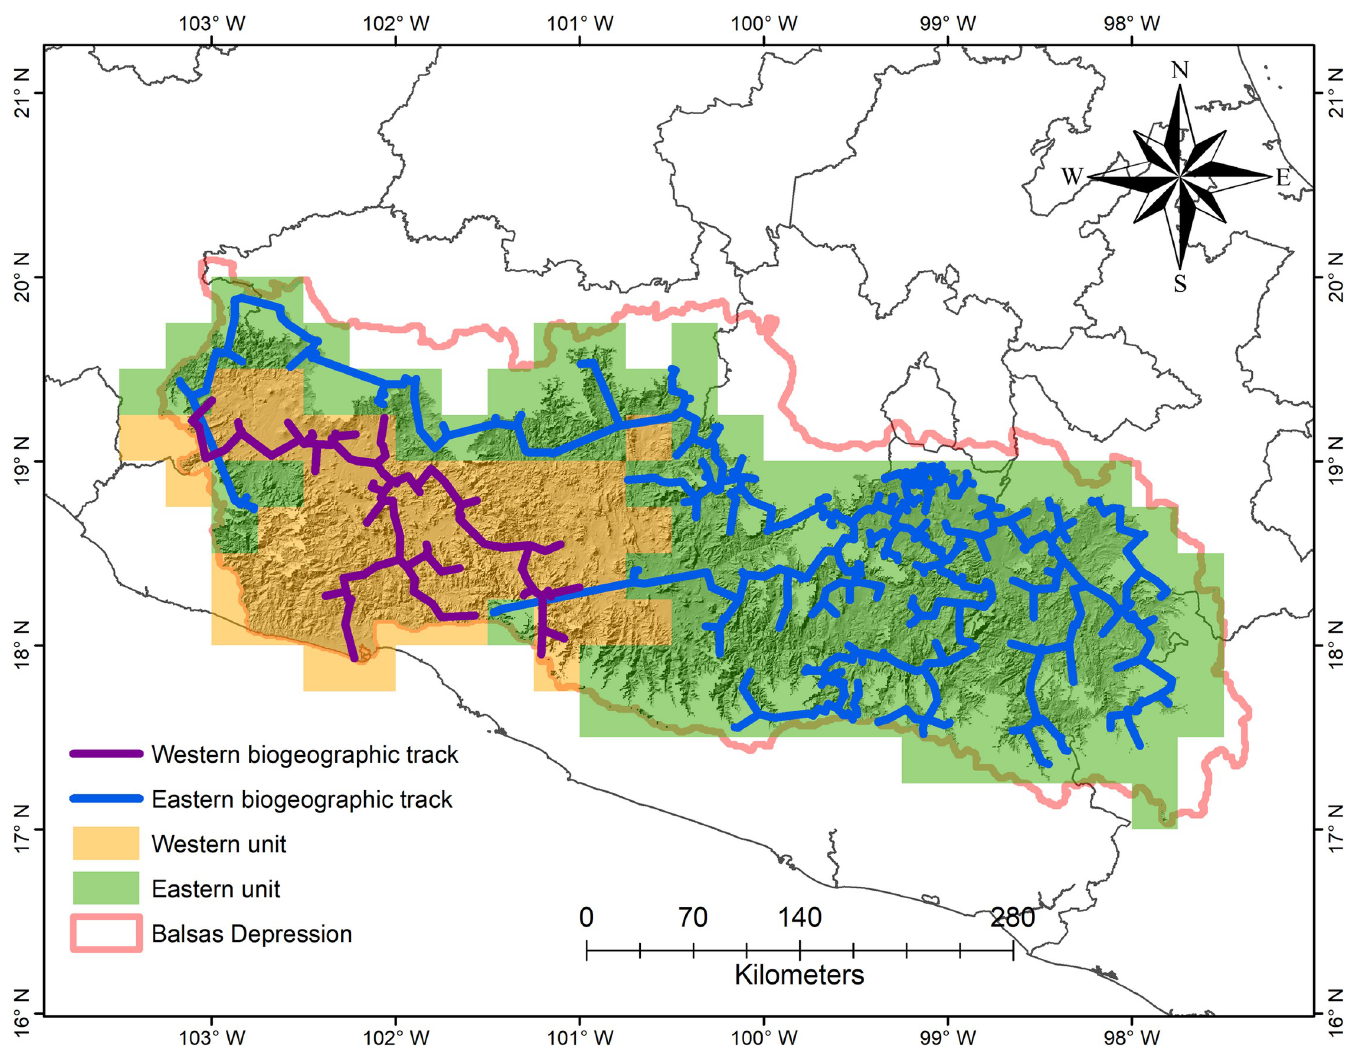
Fig 4. Phytogeographic subdivision of the seasonally dry tropical forest in the Balsas Depression, Mexico. The purple biogeographic track links by means of a minimum spanning tree the collecting points of the species exclusive to the Lower Balsas and the blue line those of the Upper